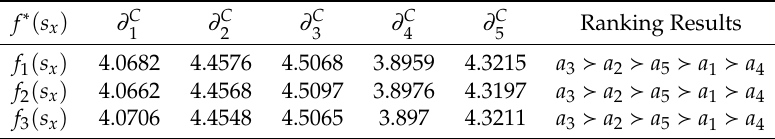
Table 9. Ranking results based on di ff erent linguistic scale